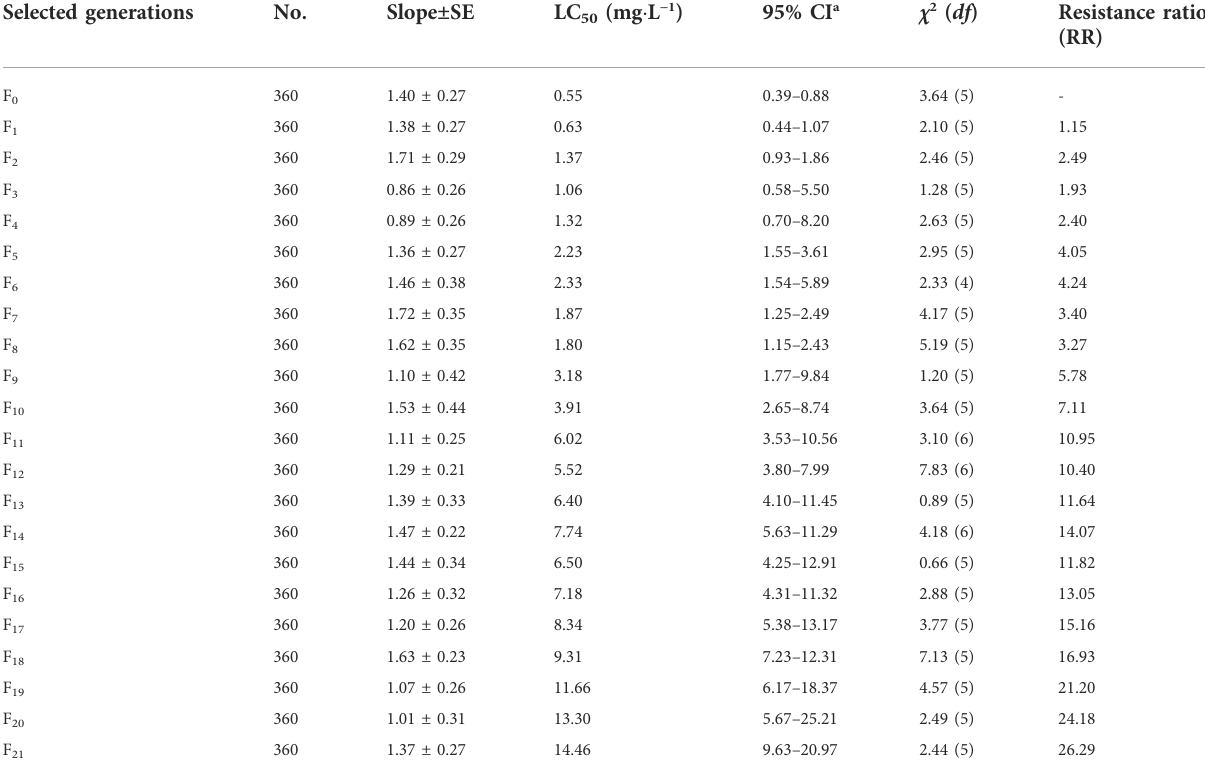
TABLE 1 The resistance development of the susceptible strain of SBPH to